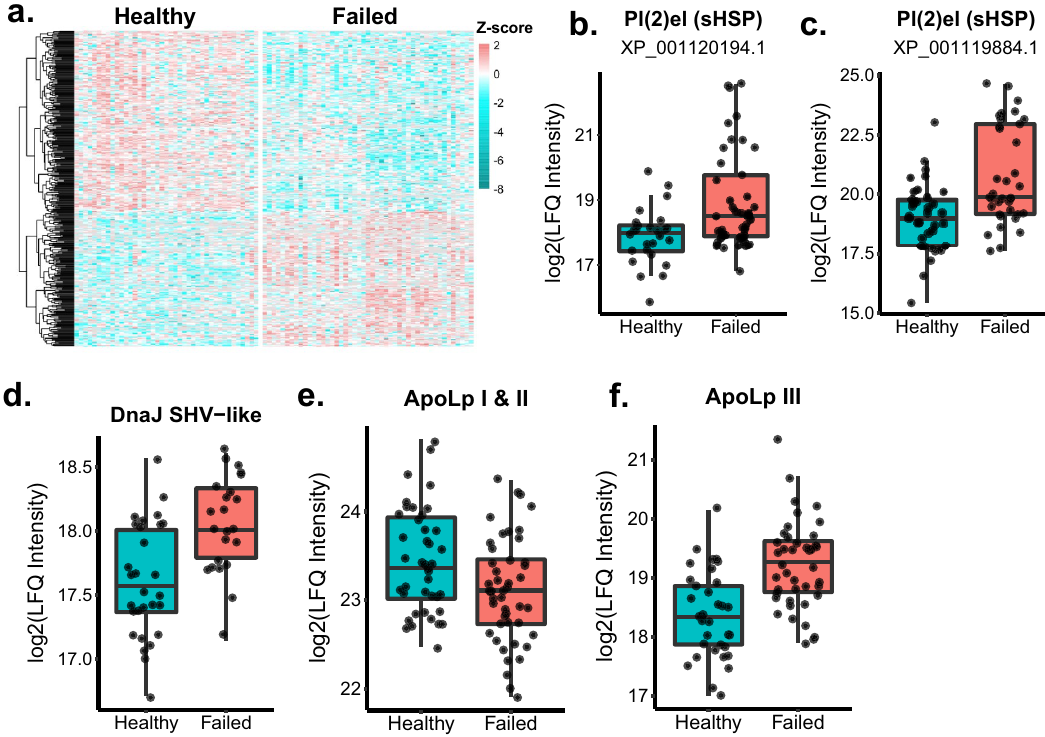
Figure 4. Changes in ovary protein expression and vitellogenin. Protein abundance was measured via LC– MS/MS using label-free quantitation (LFQ). Analysis was done on proteins identified in at least 10 samples and expression is reported as log2-transformed LFQ intensity. We used limma with status (failed vs. healthy), ovary mass, and total viral counts as fixed effects for n = 88 queens (41 healthy and 47 failed) to identify the differentially expressed proteins shown in ( a ), ( b ), and ( c ). Exact sample sizes may differ due to missing values for some proteins. The false-discovery rate (FDR) was controlled using the Benjamini–Hochberg method (5% FDR). ( a ) Protein expression patterns in ovaries of healthy and failed queens. Only proteins differentially expressed and quantified in 75% of samples are shown (387 proteins). ( b ) Proteins associated with the antiviral response are upregulated in failed queens (sHSP (XP_001119884.1): t = 3.8, adjusted p = 0.003; sHSP (XP_001120194.1): t = 3.3, adjusted p = 0.01; DnaJ: t = 4.9, adjusted p = 0.0003). ( c ) Apolipophorins I/II are involved in lipid transport and are downregulated in failed queens (t = − 2.59, adjusted p = 0.048). Apolipophorin III is an important protein for immune function and lipid transport and is upregulated in failed queens (t = 5.25, adjusted p <